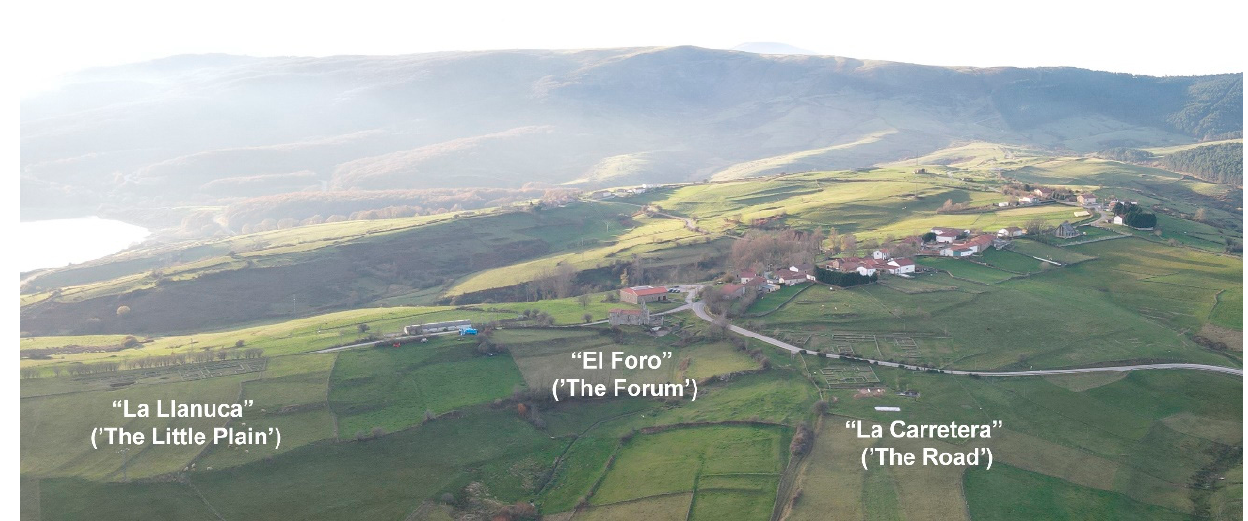
Figure 2. Distribution of the excavated areas in the archaeological site of Juliobriga.